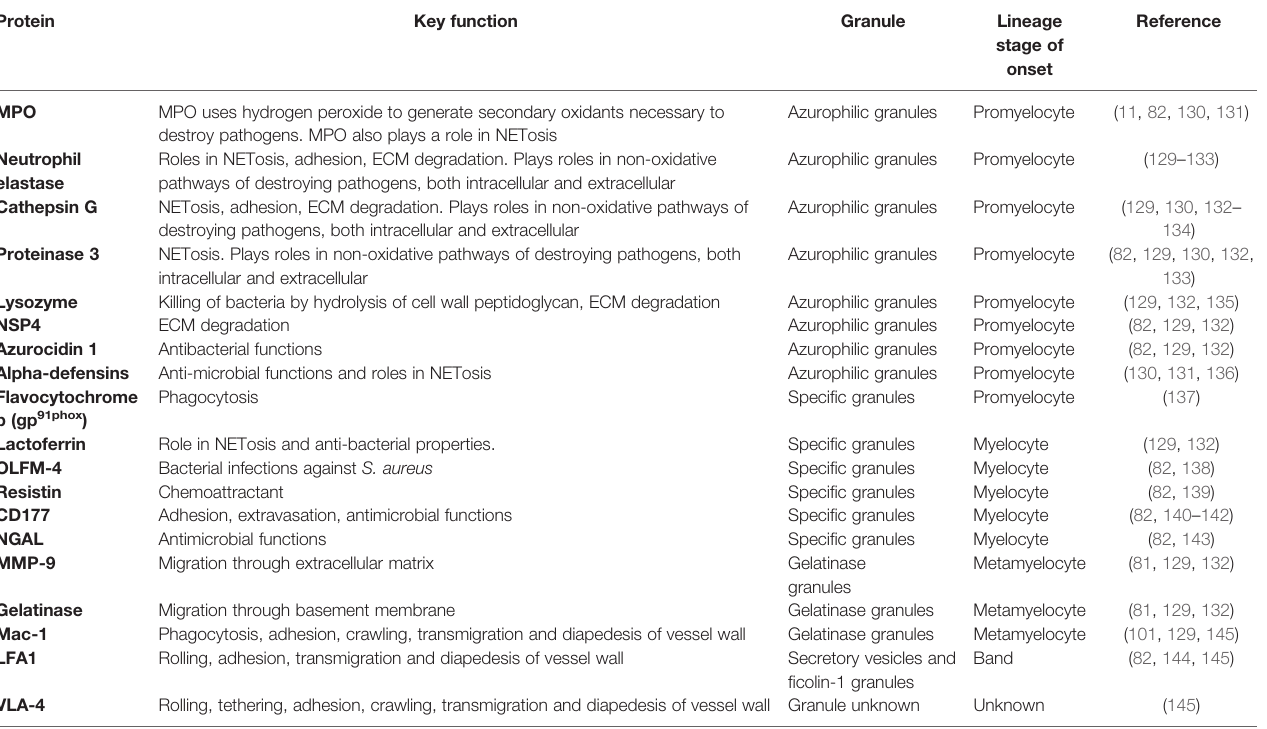
TABLE 3 | Functionality and localization of neutrophil granules. Protein Key function